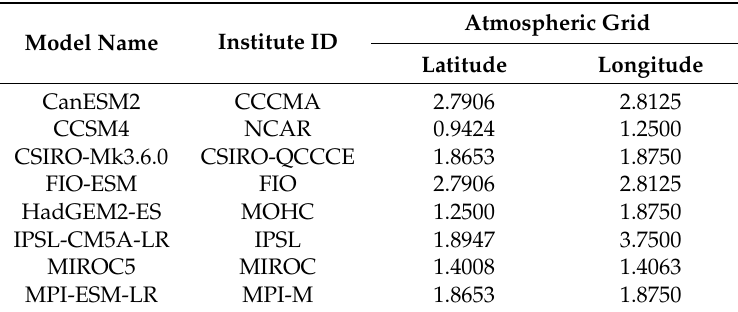
Table 1. The list of the selected CMIP5 models with individual grid resolution. At this stage, the